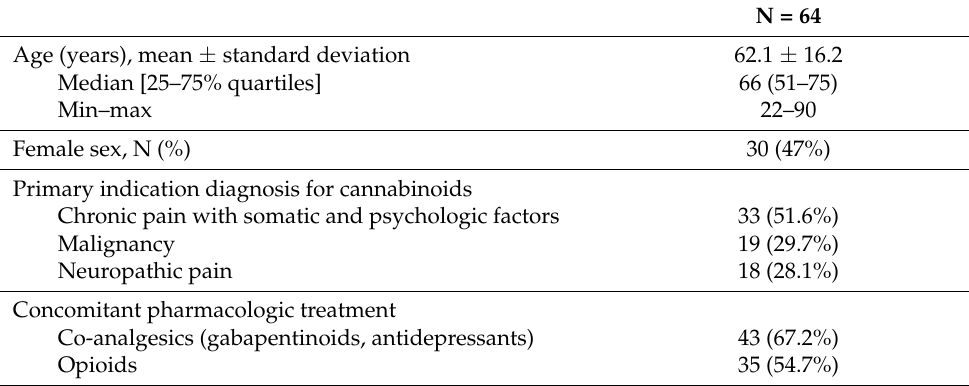
Table 1. Demographic and clinical characteristics of study population.